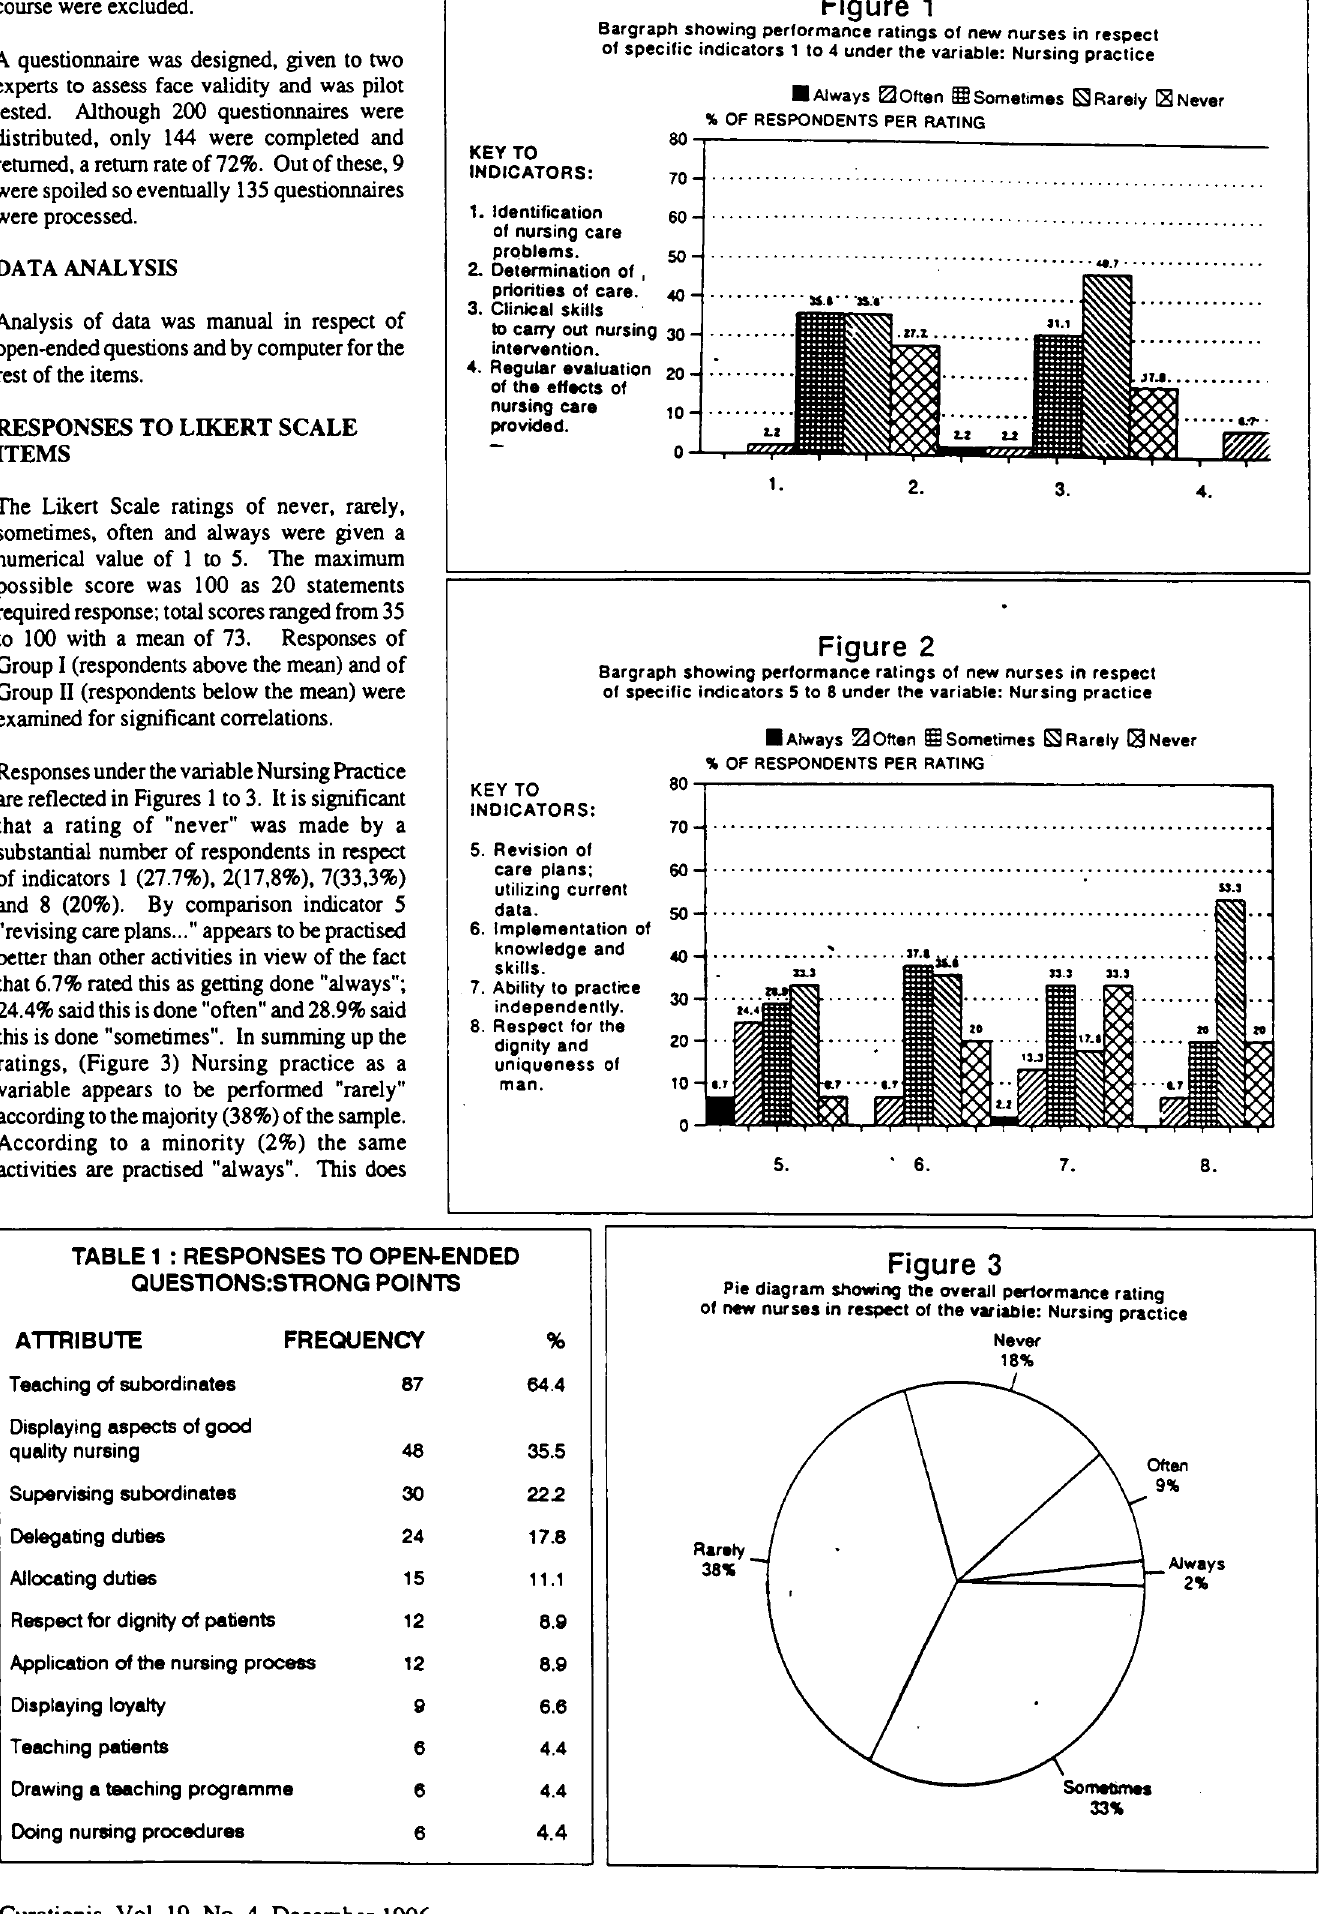
Bargraph showing performance ratings of new nurses in respect of specific indicators 1 to 4 under the variable: Nursing practice